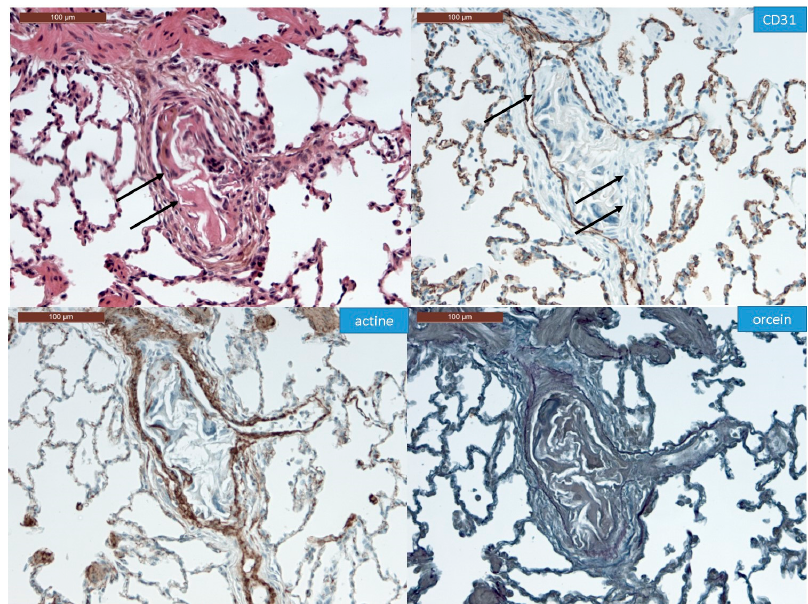
Figure 5. Immunohistochemistry of Stage I angiophagy in a large animal model of CTEPH (axial cut). The hematein–eosin–saffron stain (left upper panel) shows an intraluminal thrombus (arrows). The intraluminal embolic specimen is covered by endothelial cells highlighted with CD31 staining (arrow). There is a disappearance of endothelial cells on the arterial wall side of the embolic specimen (double arrow, right upper panel). There is neither disruption of the smooth muscle cell layer of the media as shown by the actin staining, nor of the elastic lamina stained with fuchsin–resorcin (orcein). Biomedicines 2020 , 8 , x FOR PEER REVIEW